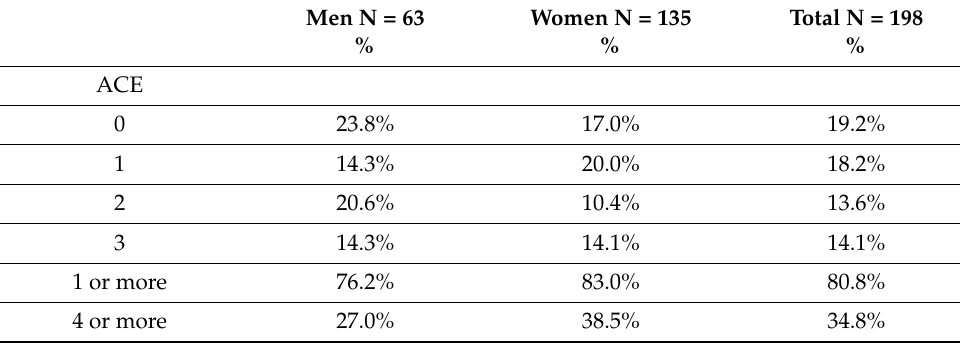
Table 2. Prevalence of ACEs considering the 10 categories.